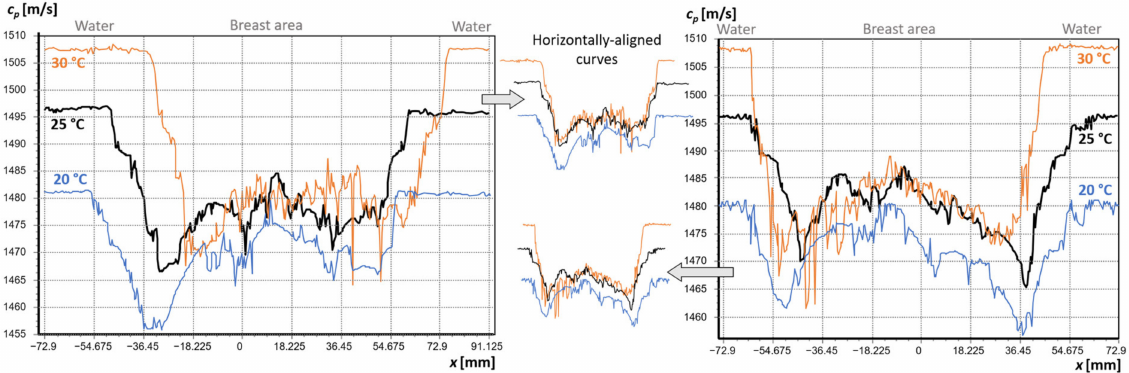
Figure 16. Visualization of ultrasound tomography projection velocity values for the breast of Patient 1 tested in vivo in water at 20 ◦ C, 25 ◦ C, and 30 ◦ C (measured data), presented in parallel ray geometry for the selected rotation angle: left—for the first coronal section from the breast base; right—for the third coronal section from the breast